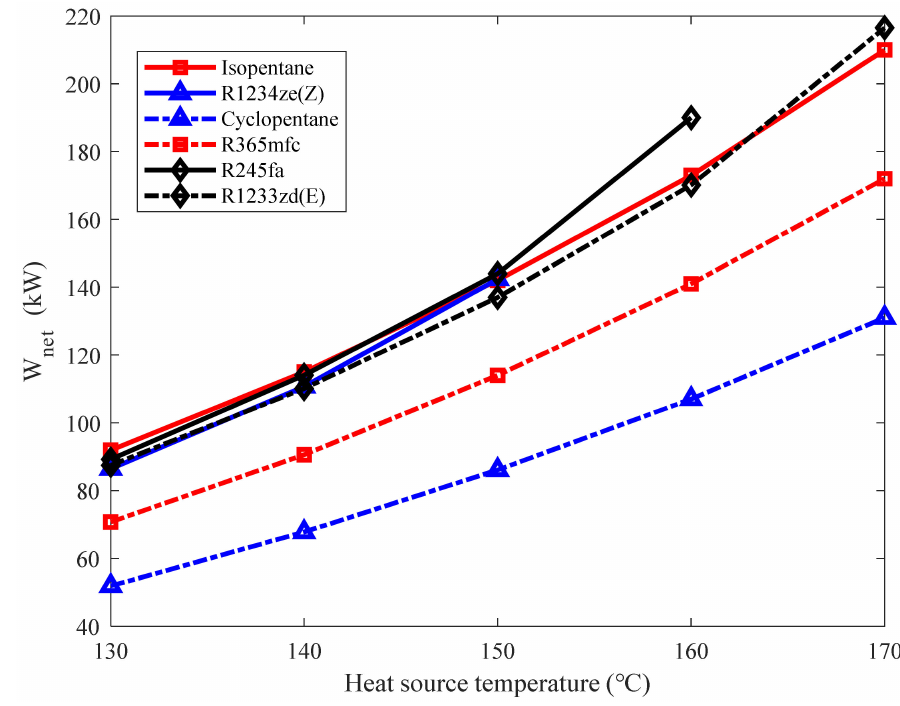
Figure 9. Effect of heat source temperature on the net power